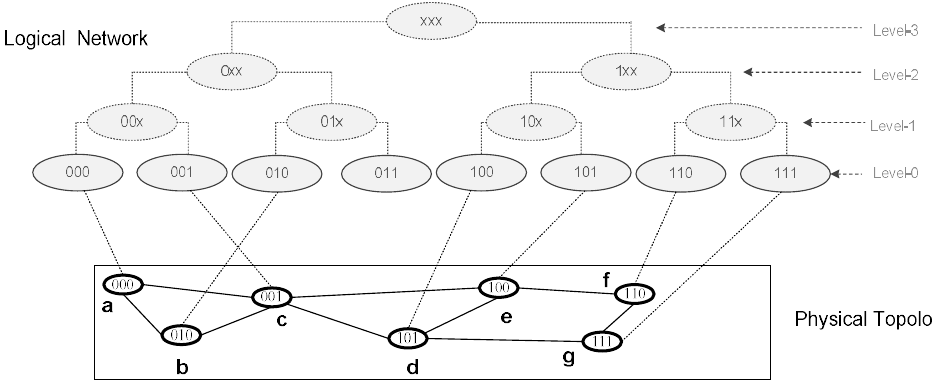
Figure 4. Physical vs. logical